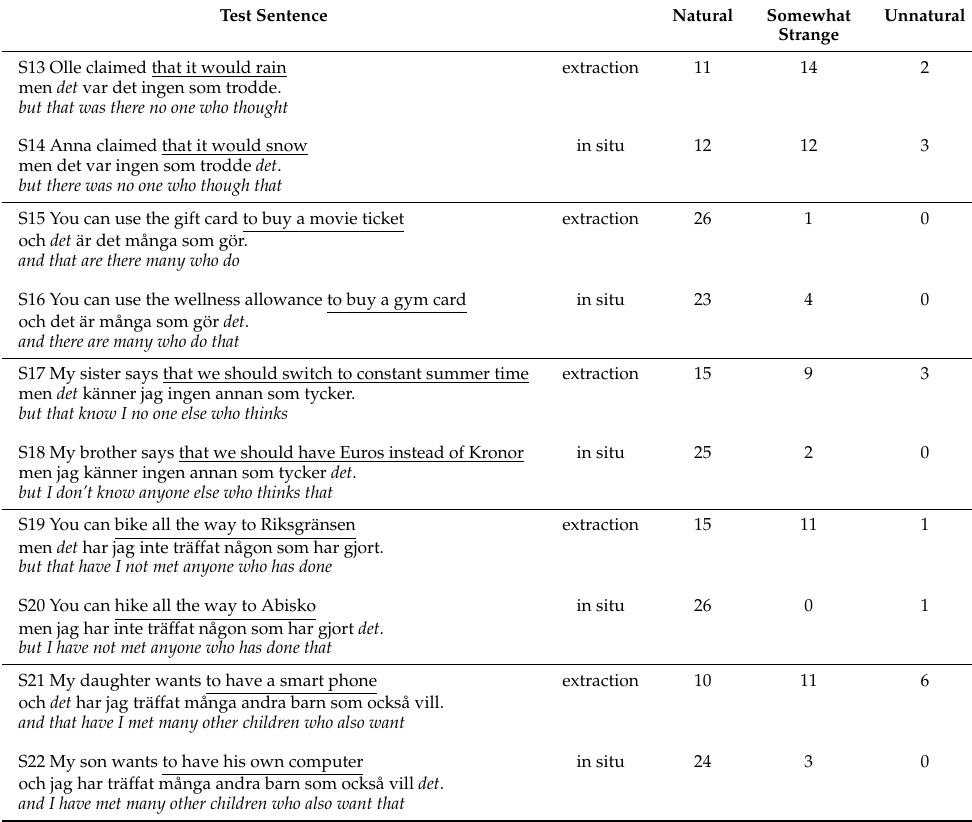
Table 2. Extraction from relative clauses: test sentences and judgments, Swedish.